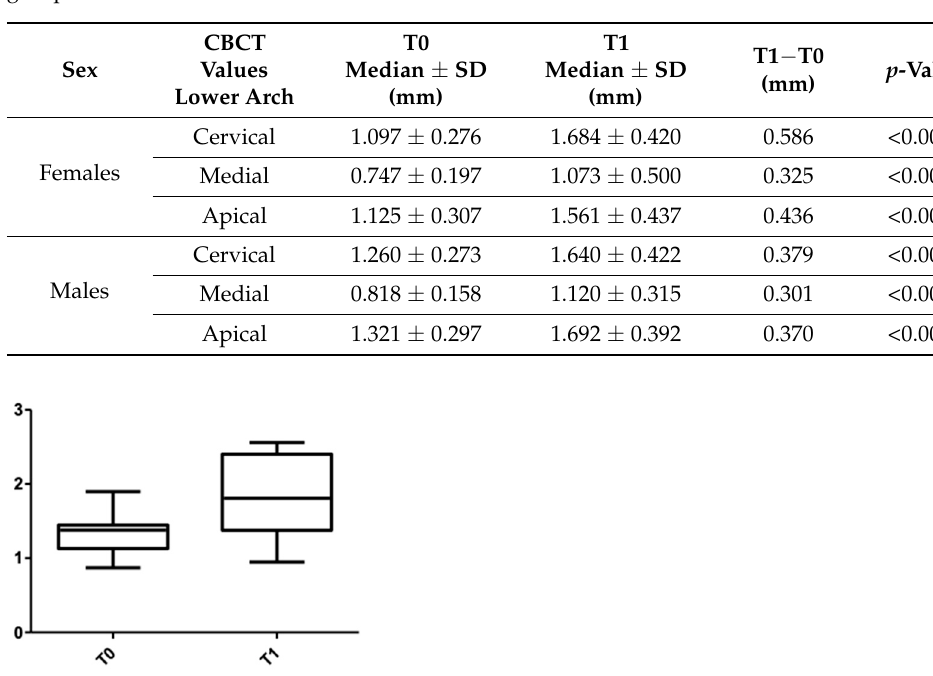
Figure 5. Cone Beam Computer Tomography values at the cervical level, upper arch, at T0 and T1 for females .